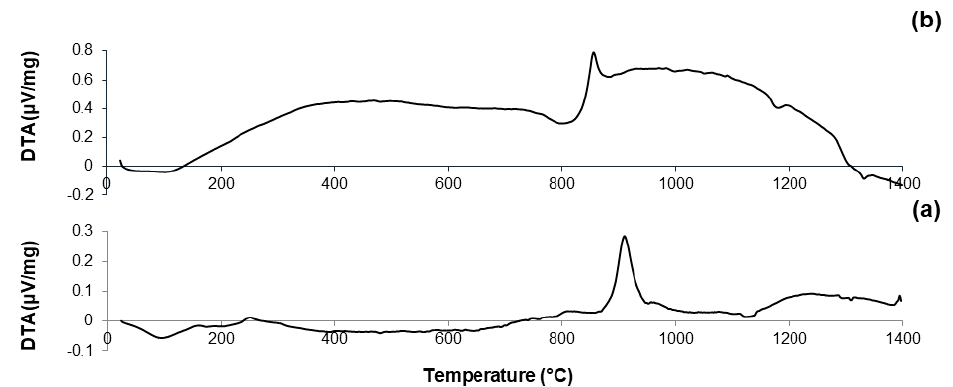
Figure 3. DTA plots of: ( a ) 60S40C-air (measurement performed in air); ( b ) 60S38C2Fe-air (measurement performed in air); ( c ) 60S38C2Fe-Ar (measurement performed in argon); ( d ) 60S30C10Fe-air (measurement performed in air); and ( e ) 60S30C10Fe-Ar (measurement performed in argon). Table 2. Characteristic temperatures of the calcined materials determined (when possible) from DTA (T g , T x , T c and T m ) and HSM plots (T FS and T MS ).